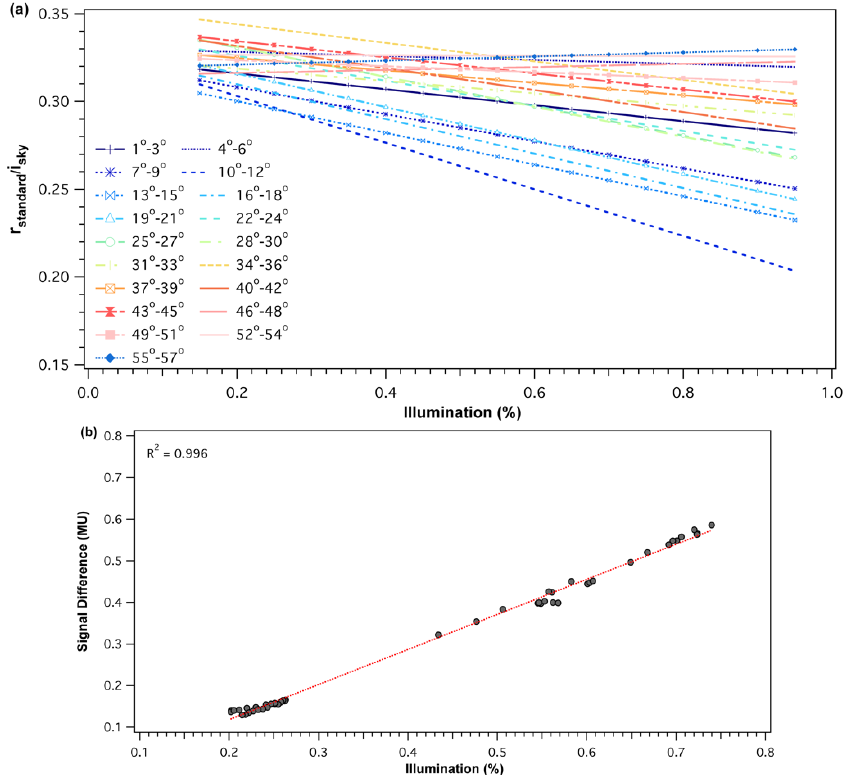
Figure 2. ( a ) Example of midday and diurnal cross-calibration functions for the 532 nm SRS-PRI fore-optic. Cross-calibration ratios are shown as a function of sun elevation (binned every 3°). Illumination of 100% represents clear and sunny sky conditions. ( b ) Example of the observed signal difference (radiance − irradiance), in machine units, as a function of illumination percentage for the 41°–43° solar elevation bin. Radiance and irradiance measurements were collected from the 532 nm SRS-PRI sensor pair.